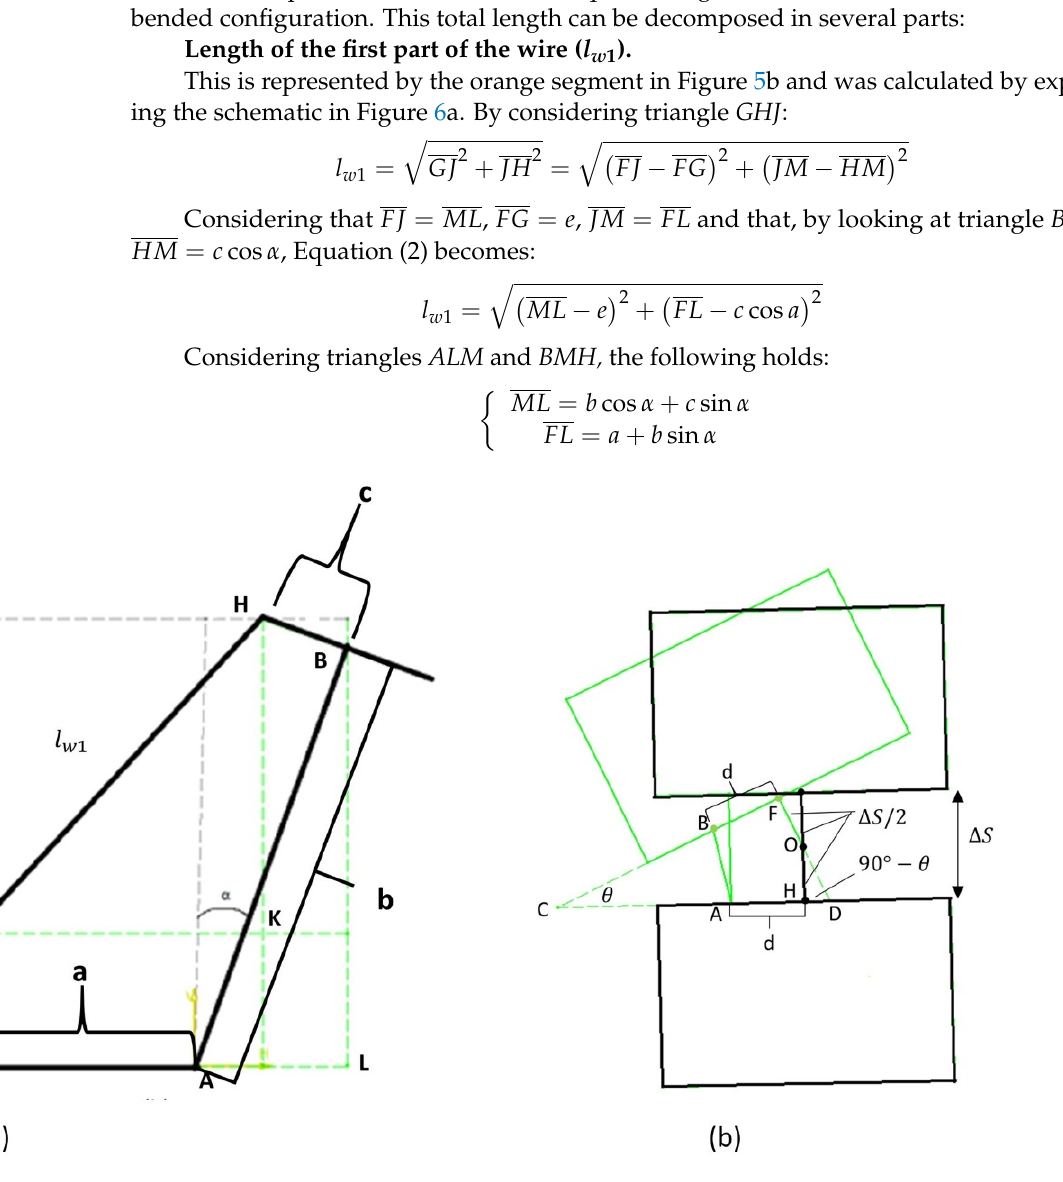
(6) Lengths of wire parts between Segments 1 and 2, and between Segments 2 and 3 ( 𝒍 𝒘 𝟏(cid:3127)𝟐 and 𝒍 𝒘 𝟐(cid:3127)𝟑 respectively). These wire parts are highlighted in orange in Figure 5(c). For the calculation, the schematic of Figure 6(b) was used. Black blocks represent the relative position of segments